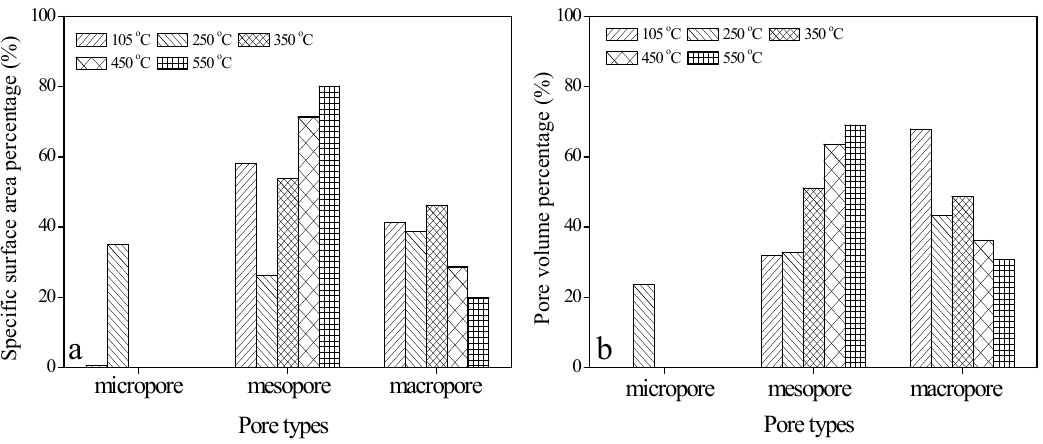
Figure 5. Specific surface area ( a ) and pore volume distribution of micropore, mesopore, and macropore in bio-schwertmannite ( b ) before and after heating.